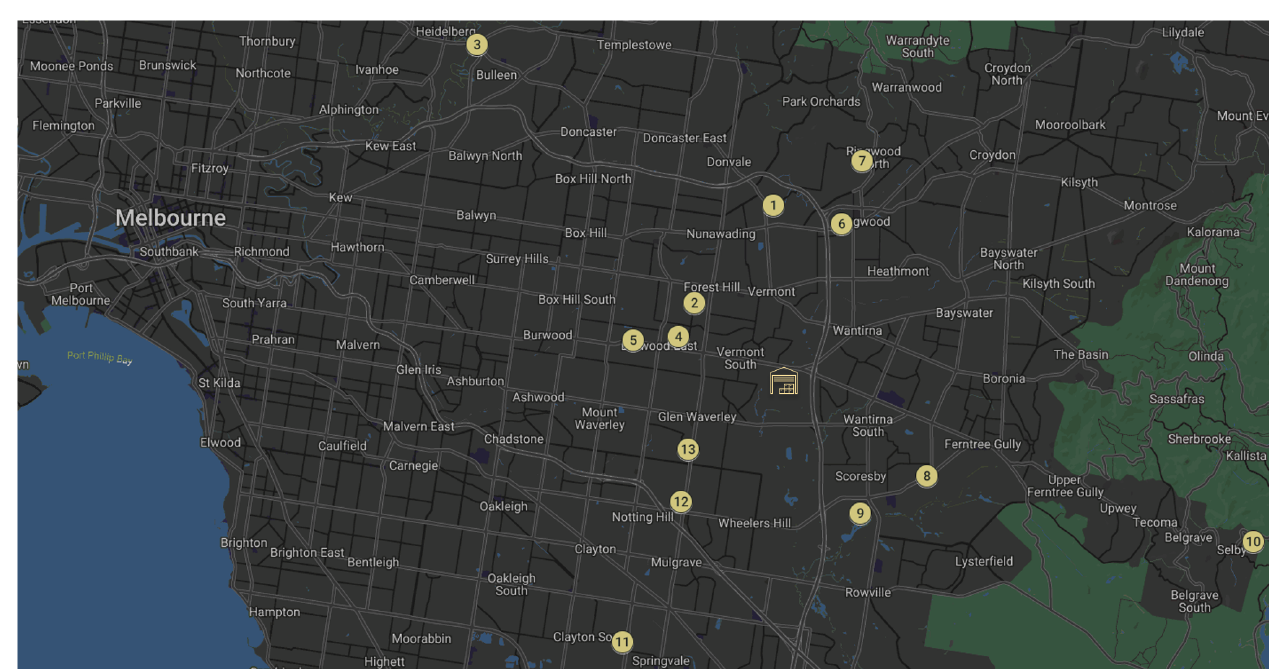
Figure 5. The warehouse location and the order of 13 last mile parcel